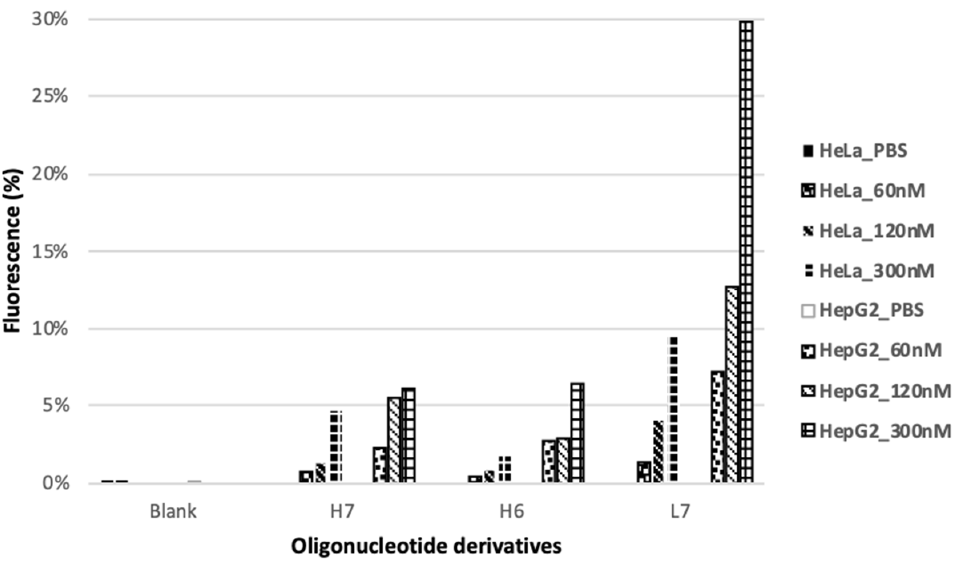
Figure 6. Cytometry assay evaluating the internalization of H7 (L193), H6 (L235), L7 (FAM-G 6 -Luc, FAM derivative of L3) at 60, 120 and 300 nM in HeLa and HepG2 cell lines.